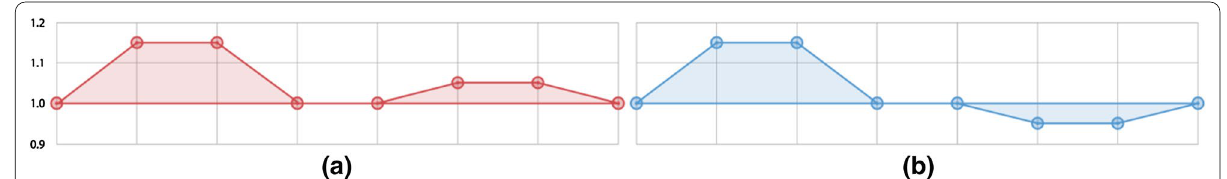
Fig. 22 In a, coupling length deviates from a median value at two separate points along the trackway with the same sign, while in b the deviations have opposite sign. Note that the area under the two curves is identical